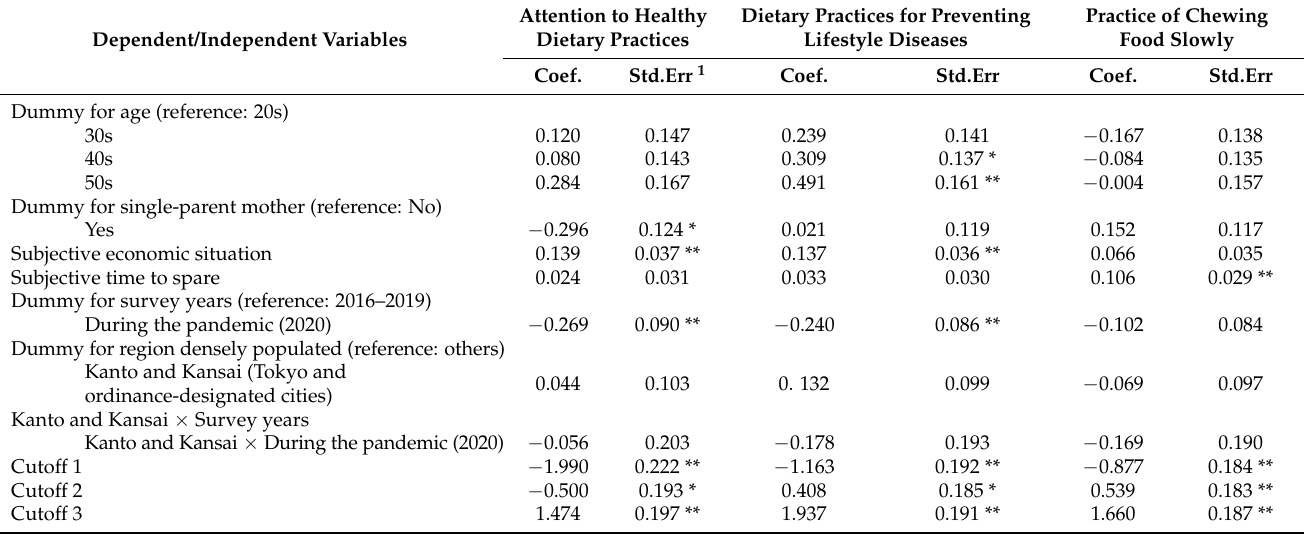
Table 3. Estimation results (ordered probit